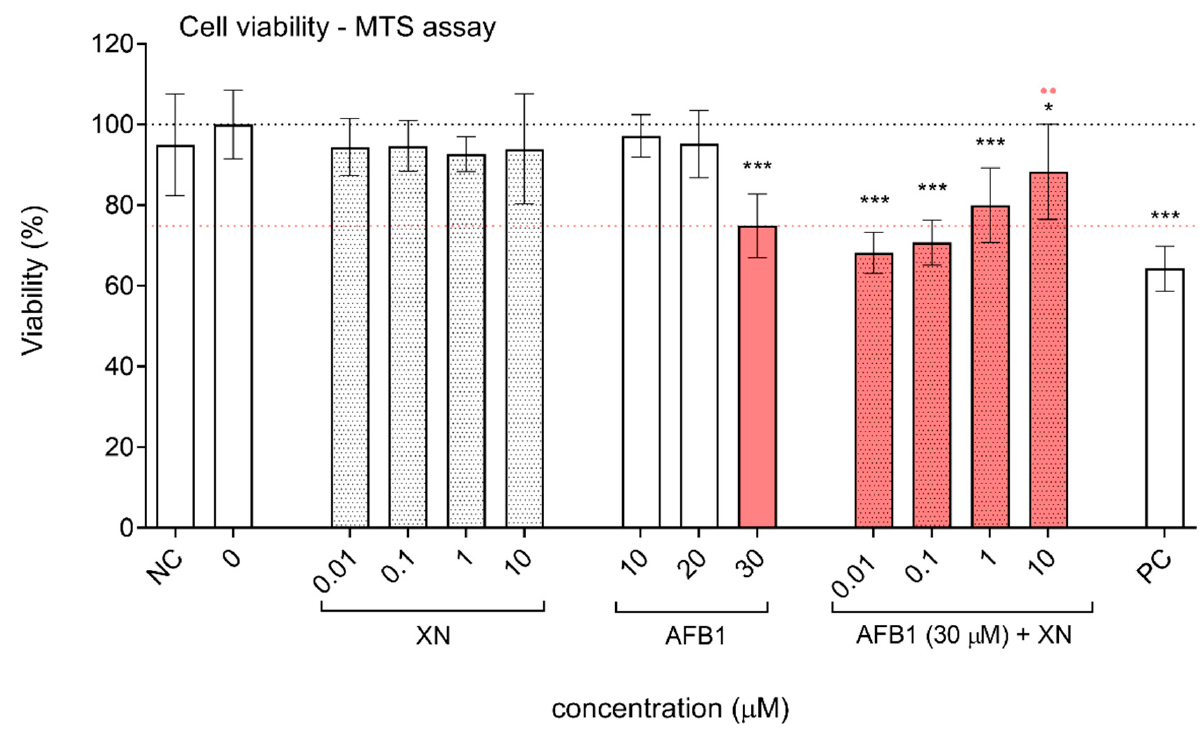
Figure 5. Protective effects of XN against AFB1 ‐ induced cytotoxicity. The effects of XN (0.01, 0.1, 1 and 10 μ M), AFB1 (10, 20 and 30 μ M), and the AFB1 (30 μ M)—XN (0.01, 0.1, 1 and 10 μ M) combinations on the viability of HepG2 cells after 24 h of exposure, presented as a percentage of the solvent control (0; 1% DMSO—upper dashed line). NC is the negative control (growth medium). PC is the positive control—ET (25 μ g/mL). The lower red dashed line represents the average reduction in cell viability by AFB1 (30 μ M). The asterisks (*) denote statistically significant difference (ANOVA and Dun ‐ net’s multiple comparison test) between the solvent control and the AFB1, XN, and their combinations exposed cells (* p ≤ 0.05; *** p ≤ 0.001). The red dots (•) denote a statistically significant difference (ANOVA and Dunnet’s multiple com ‐ parison test) between the cells exposed to AFB1 (30 μ M) and to the AFB1 ‐ XN combinations (•• p ≤ 0.01).